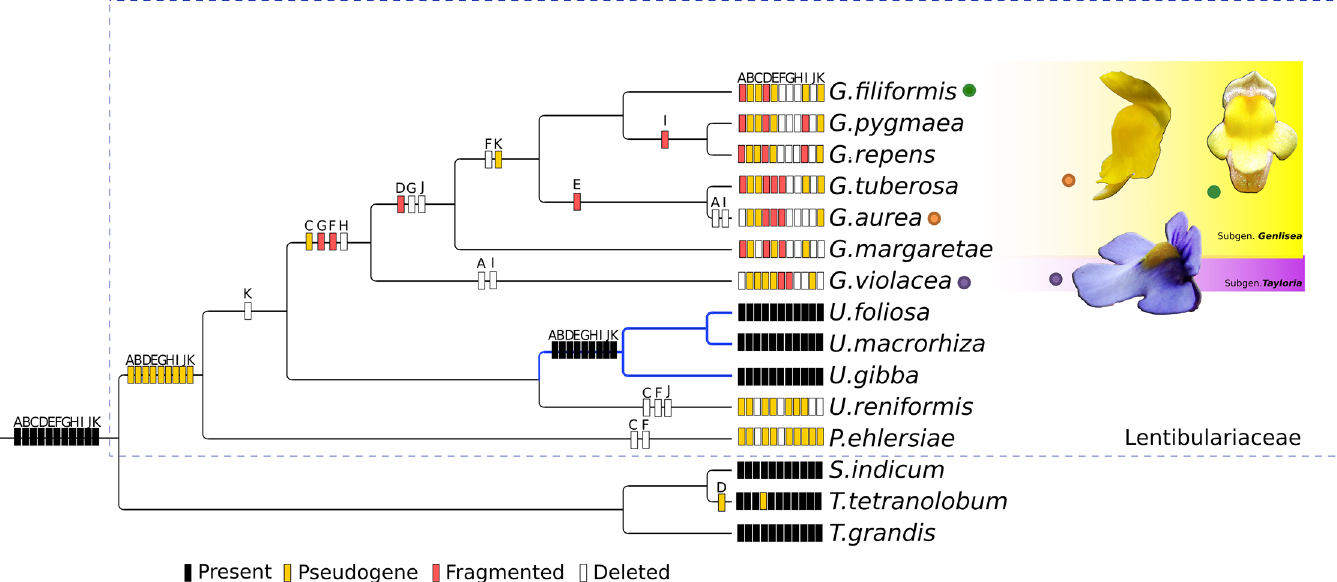
Fig 4. Phylogenomics of whole chloroplasts of Genlisea species and ndh genes evolution. The boxes indicate the ndhA , ndhB , ndhC , ndhD , ndhE , ndhF , ndhG , ndhH , ndhI , ndhJ and ndhK genes. Black boxes denote intact genes, yellow boxes pseudogenized genes, red boxes fragmented and white boxes indicatedeletedgenes. Blue lines indicatethe aquatic Utricularia species with complete ndh repertoire. Numbers of support values are all 100%for Bayesianinference, maximum likelihoodand maximum parsimony bootstrap, except for outgroupclade S . indicum and T . tetranolobum with parsimony bootstrapvalue of